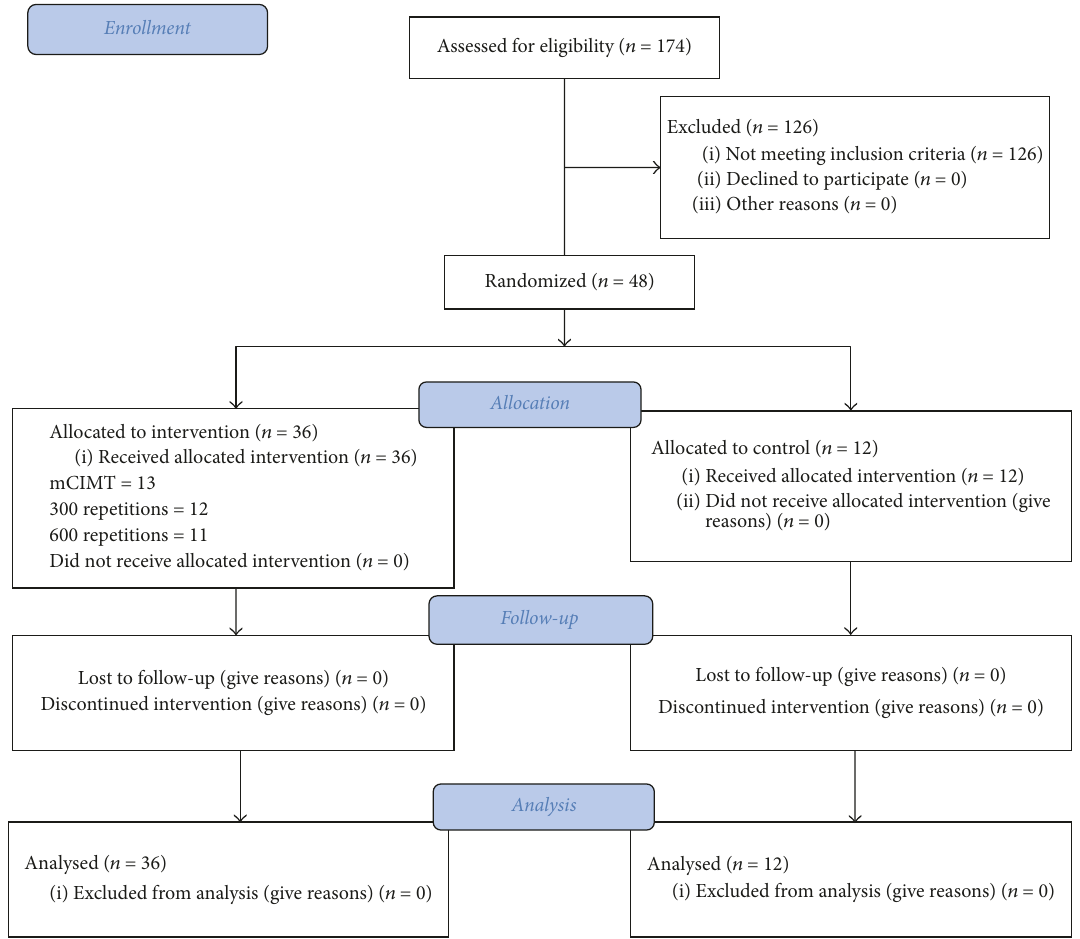
Figure 1: The study’s flow